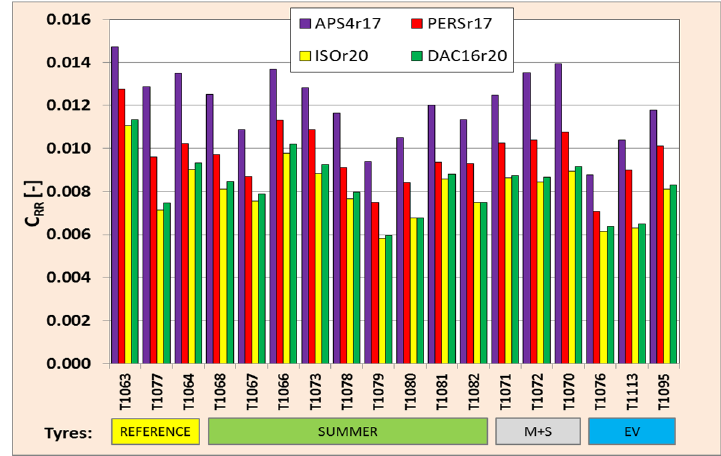
Figure 8. Results of laboratory rolling resistance measurements for passenger car tires (EV-tires designed for electric vehicles).